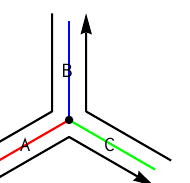
Figure 3: Definition of the orientation of the loops for a black vertex (the definition is opposite on white vertices).